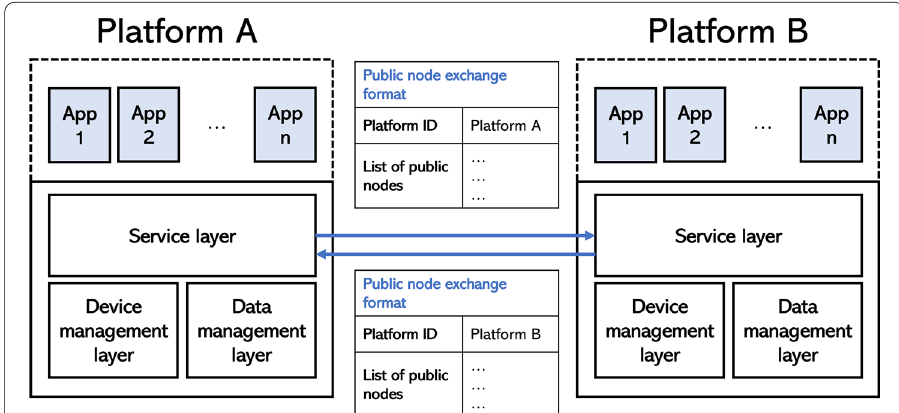
Fig. 5 Openness of the proposed framework for cross-platform data